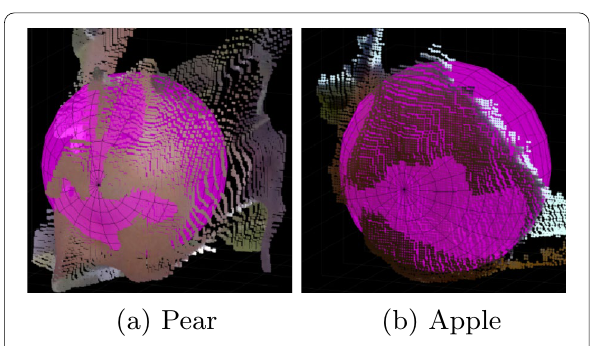
Fig. 13 Details of sphere shape